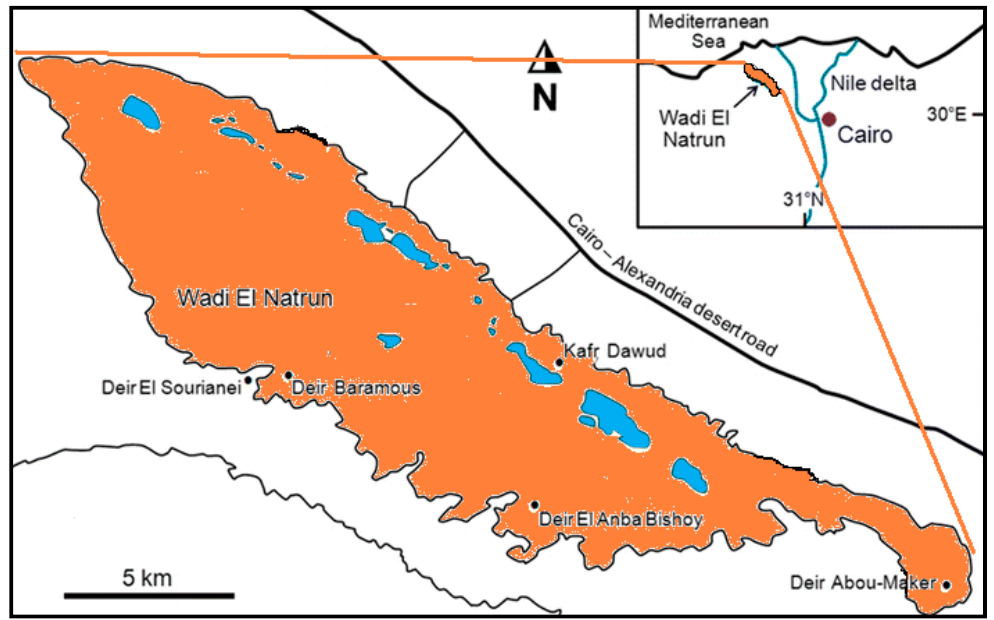
Figure 1. Geographical location of the study site for deficit irrigation treatments of apricot at Wadi El Natrun, El Beheira Governorate, Egypt. Table 1. The soil physical and chemical characteristics of the study site for deficit irrigation treatments of apricot at Wadi El Natrun, El Beheira Governorate,